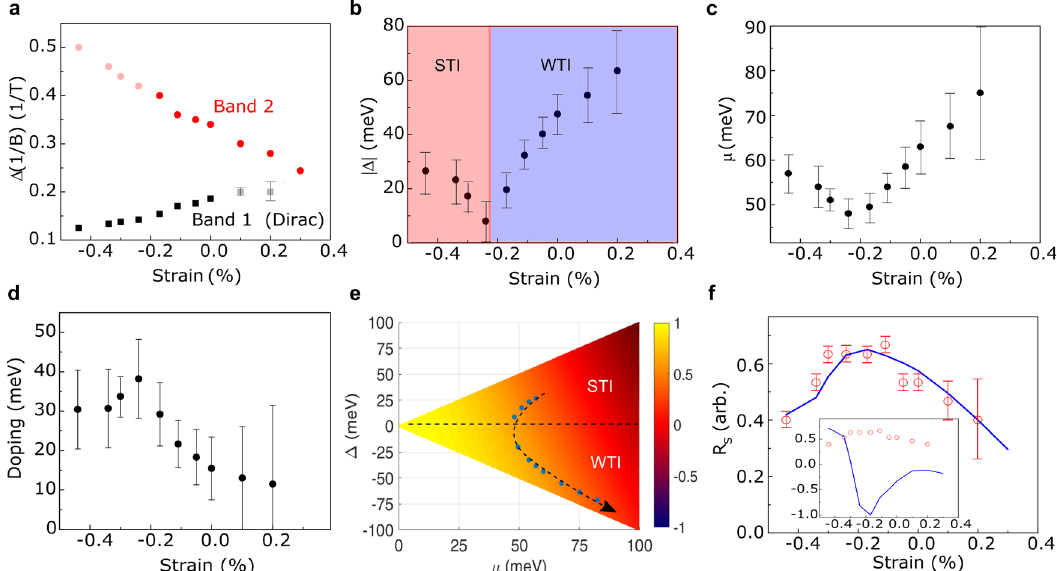
Fig. 3 Strain tuning of band structure and spin-dependent Berry phase. a Strain dependence of SdH oscillation period in inverse magnetic fi eld, for the Dirac band (band 1) and the trivial band (band 2).The results are obtained by simulating the SdH oscillations. The semitransparent data points correspond to when the band has relatively small contribution to the SdH oscillations. The vertical error bars present the interval beyond which the simulated SdH oscillations become noticeably different from the data. For low strains, the error bars are too short to be displayed. The mean values and uncertainties for the other simulation parameters are listed in Supplementary Note 4. b , c Strain tuning of mass gap size and Fermi energy. The mass gap and the Fermi energy are obtained by simulating the magnetic fi eld and temperature dependence of the SdH oscillation curves with the two-component LK formula. Tuning the external strain from compressive to tensile, the mass gap closes and reopens at around − 0.2%, consistent with the STI-WTI topological phase transition. The vertical error bars are determined through standard error propagation. d Strain dependence of doping energy, the energy of the Fermi surface counted from the bottom of the conduction band. The vertical error bars are determined through standard error propagation. e Theoretical intensity plot of SdH oscillation amplitude reduction factor from Zeeman effect, R S , as functions of Fermi energy and mass gap. The dotted line shows the boundary between the STI phase (positive mass gap) and the WTI phase (negative mass gap). The symbols in the mass gap-Fermi energy parameter space correspond to the experimental data points at various external strains, evolving following the arrow from compressive to tensile. By convention we assign a negative sign to the mass gap on the WTI side with external strain larger than ≈ − 0.2%. f Theory(solid lines)/experiment(open symbols) comparison of R R S as functions of mass gap and Fermi energy at various strains. The experimental values of S are scaled by a common constant factor of 0.6 for comparison with the theory. The theoretical model qualitatively reproduces the experiment results by considering the spin-dependent Berry phase. By contrast, the inset shows the theoretical curve without considering the spin-dependent phase, which fails to explain the experimental data (see Supplementary Note 6). The vertical error bars are determined through standard error propagation.